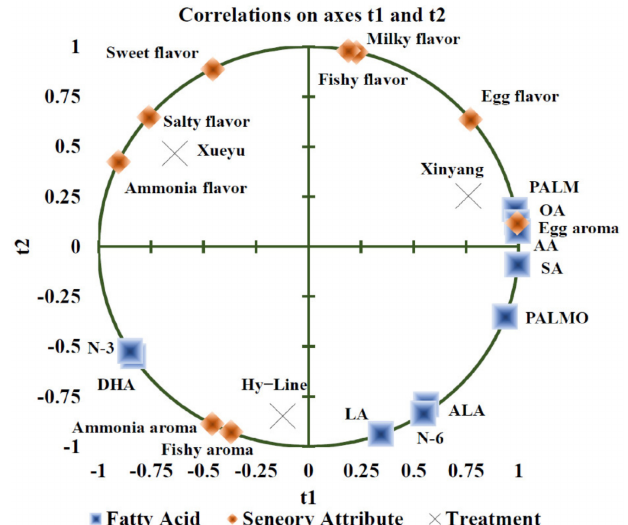
Figure 4. An overview of the correlation loadings from PLS analyses with fatty acid as X-variables and sensory attributes as Y-variables. Note: Hy-Line: Hy-Line Brown; Xueyu: Xueyu White; Xinyang: Xinyang Blue. PALM: Palmitic acid; PALMO: palmitoleate acid; SA: stearic acid; OA: oleic acid; LA: linoleic acid; AA: arachidonic acid; ALA: α -linolenic acid; DHA: docosapentaenoic acid; N-3: ALA + DHA; N-6: LA +